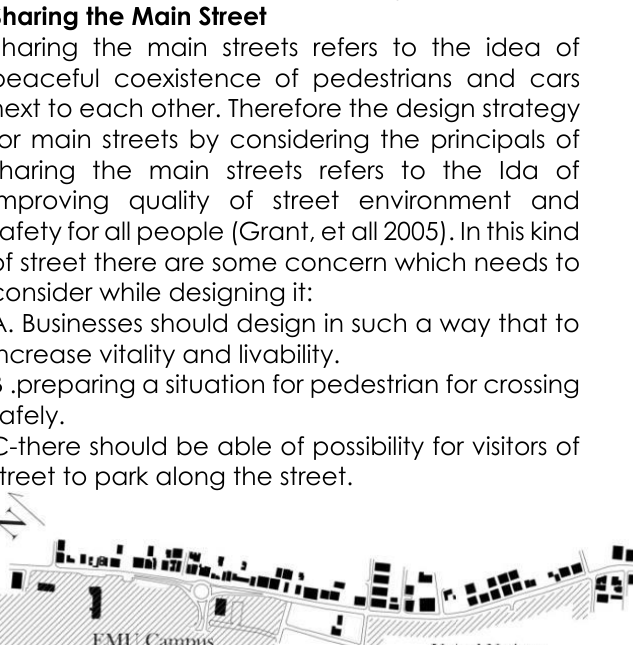
Figure 8. Examples of shares zones in urban spaces.